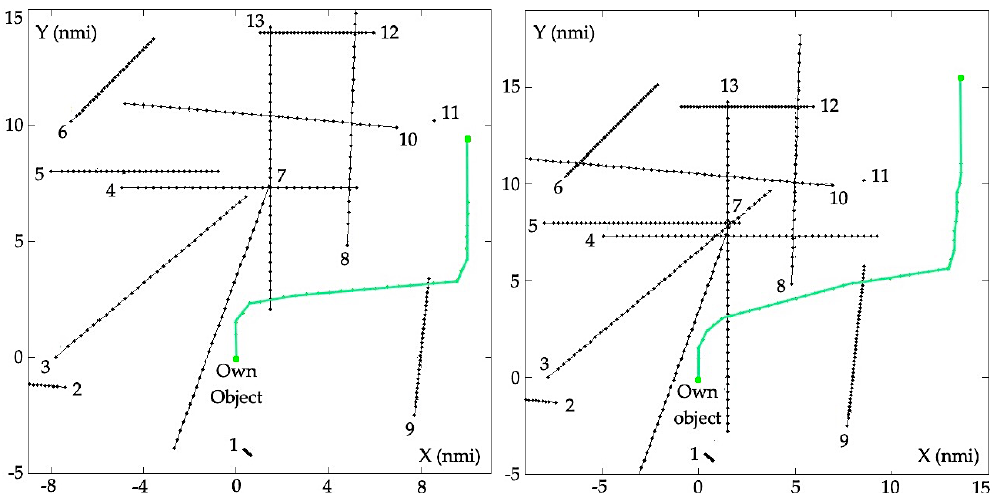
Figure 10. Object game trajectories calculated according to the mg nc algorithm of non-cooperative matrix game control: on the left—with good visibility at sea, with the final payo ff of the game ε f = 9.2 nmi achieved, assessing deviation safe trajectory from reference cruise route; on the right—with limited visibility at sea, with the final payo ff of the game ε f = 13.8 nmi.